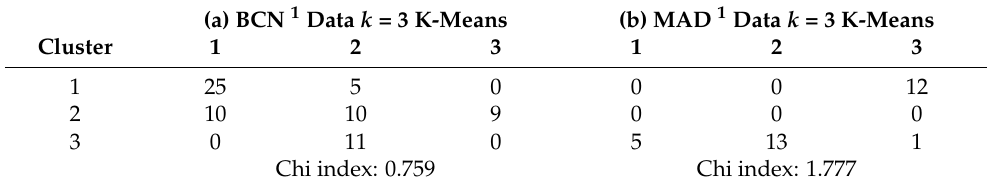
Table 8. Comparison Federated Data k = 3 Hierarchical Agglomeration (in rows) with isolation BCN 1 or MAD 1 data clustering optimal